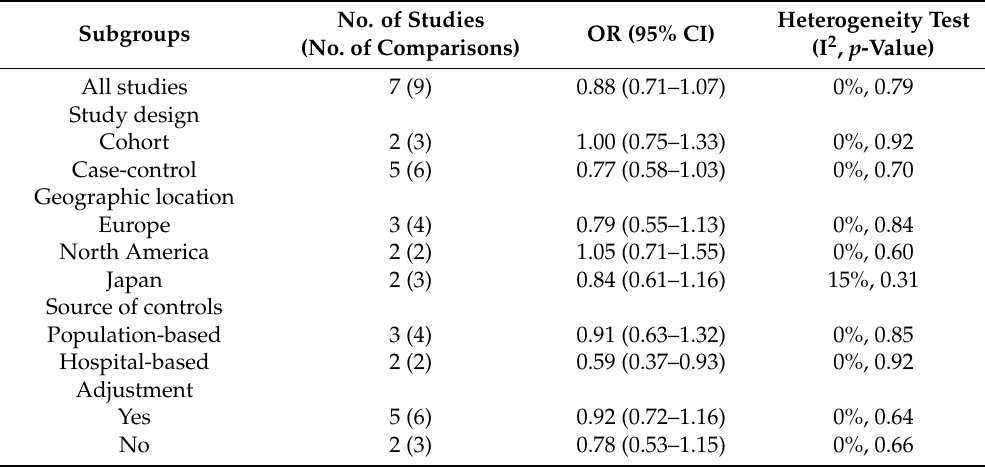
Table 2. Subgroup analysis for association between coffee consumption and thyroid cancer risk.